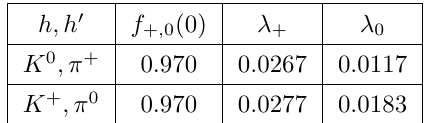
Table 10 . Best (cid:12)t parameters for the form factors (C.20) of D transitions [106{108].